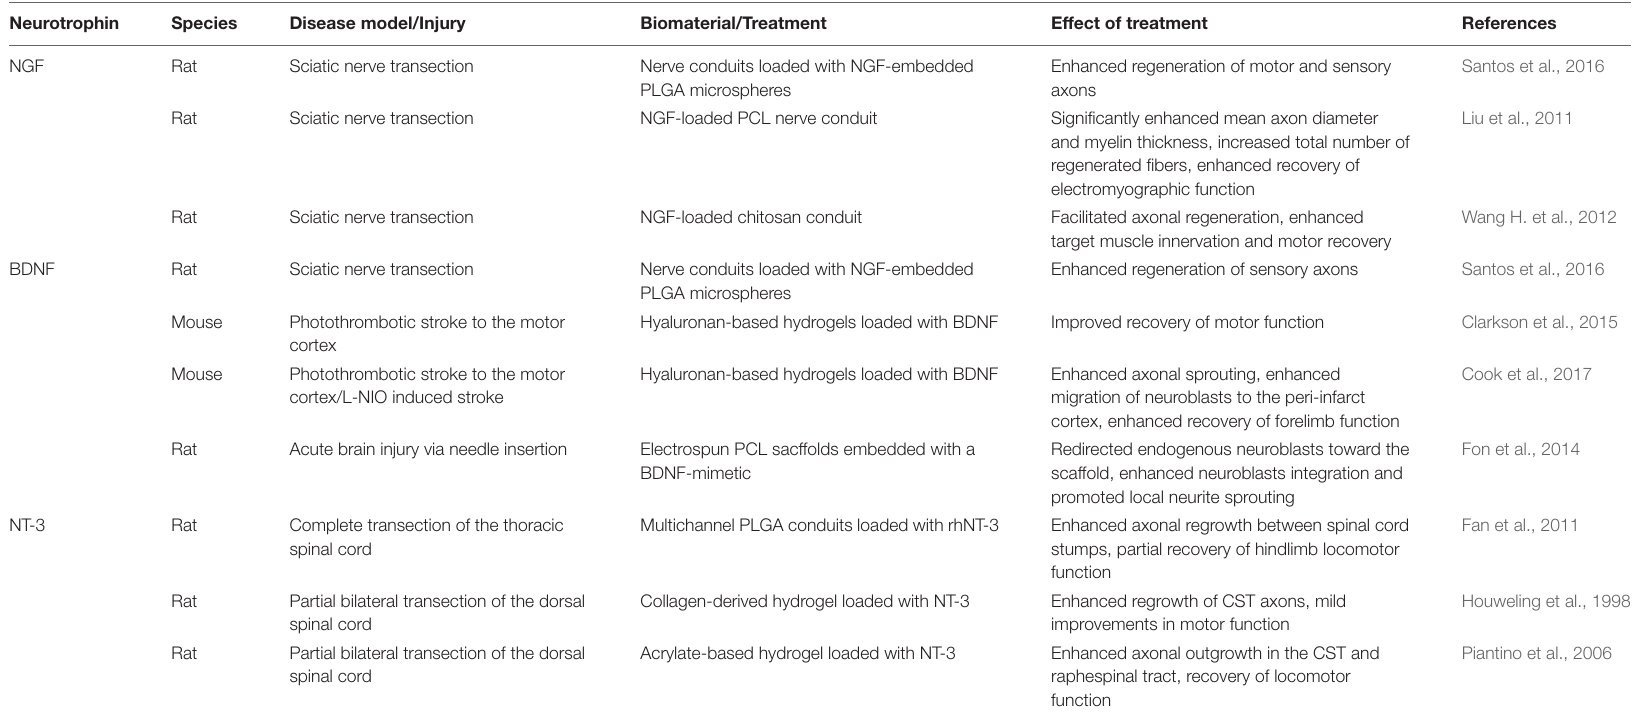
TABLE 2 | Examples of biomaterial-based neurotrophin treatments for regeneration and repair following CNS disease/injury in vivo . Neurotrophin